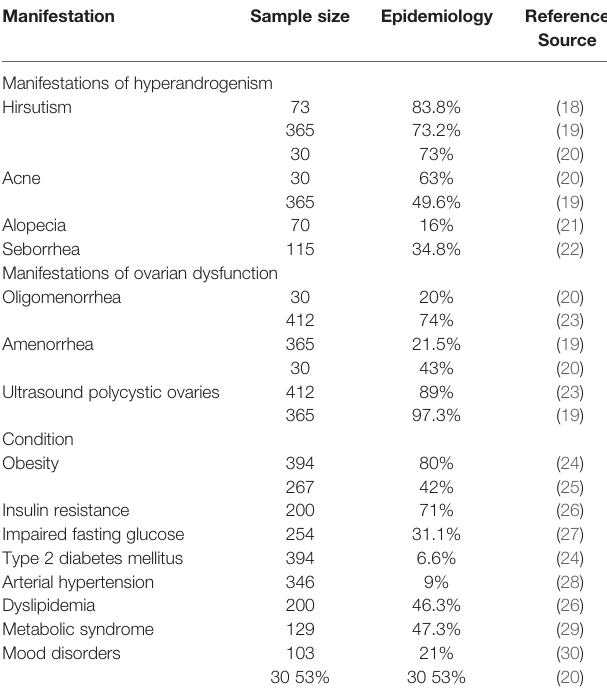
TABLE 1 | Summary of the PCOS diagnostic